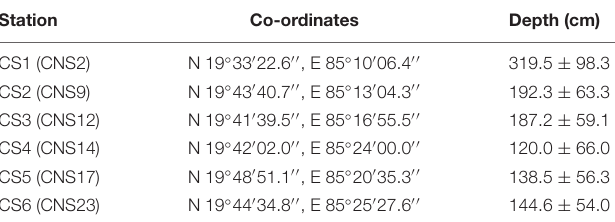
TABLE 1 | Station location and respective average depth of water column; Corresponding station nomenclature used by Ansari et al. (2015, 2017) are mentioned within